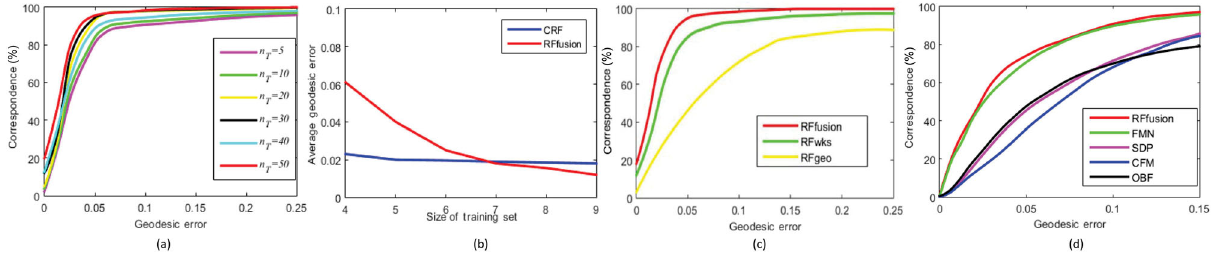
Fig. 9 (a) Correspondence errors with different forest sizes for the TOSCA dataset. (b) Average geodesic errors corresponding to various sizes of training sets for the proposed method (RF fusion ) and a classification random forest (CRF) [9]. (c) Comparison of pairwise correspondence errors with different feature channels on human motion data [49]. (d) Comparison of consistent correspondence errors on the SHREC-NonSym dataset by the proposed method, and FMN [35], SDP [34], CFM [50], and OBF [36] methods.